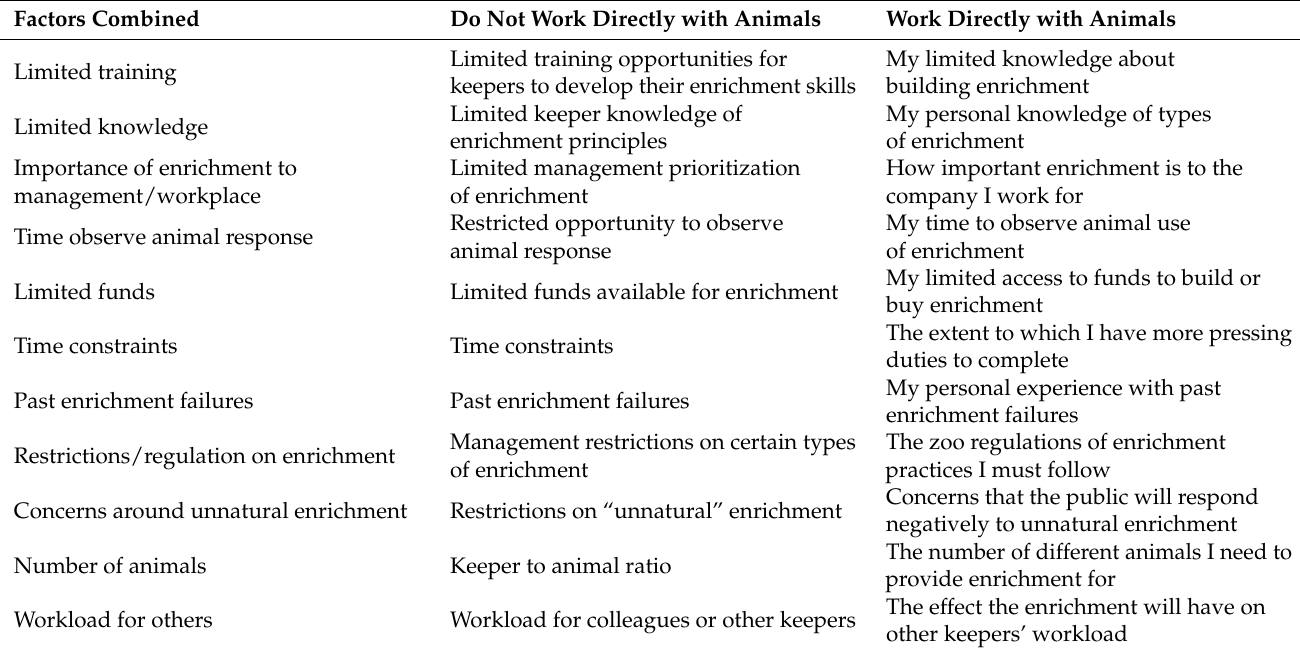
Table 1. Factors affecting the use of cognitive enrichment that were presented to those who work with animals and those who do not, which have been combined for